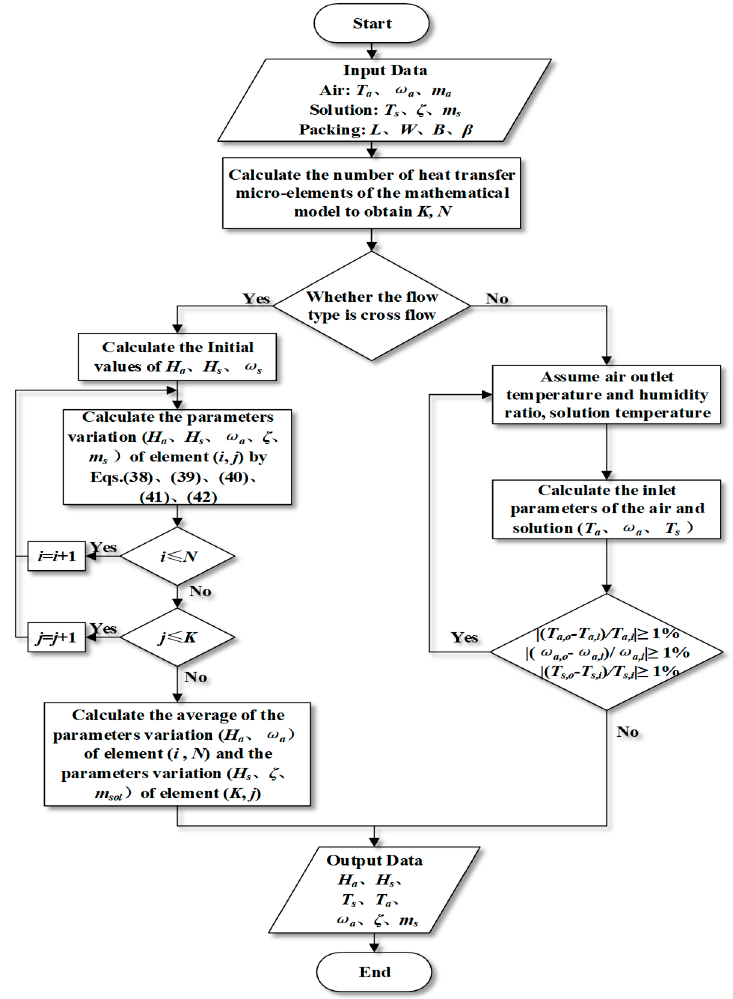
Figure 5. The flowchart of cross-flow and counter-flow HST program.